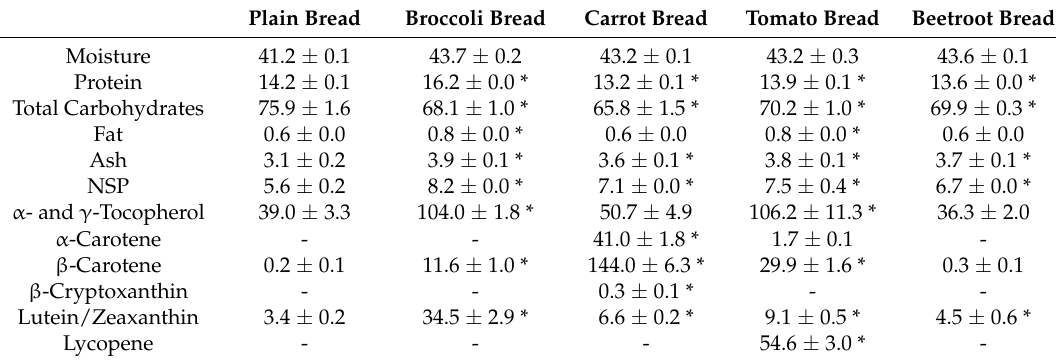
Table 1. Compositional information of the breads.